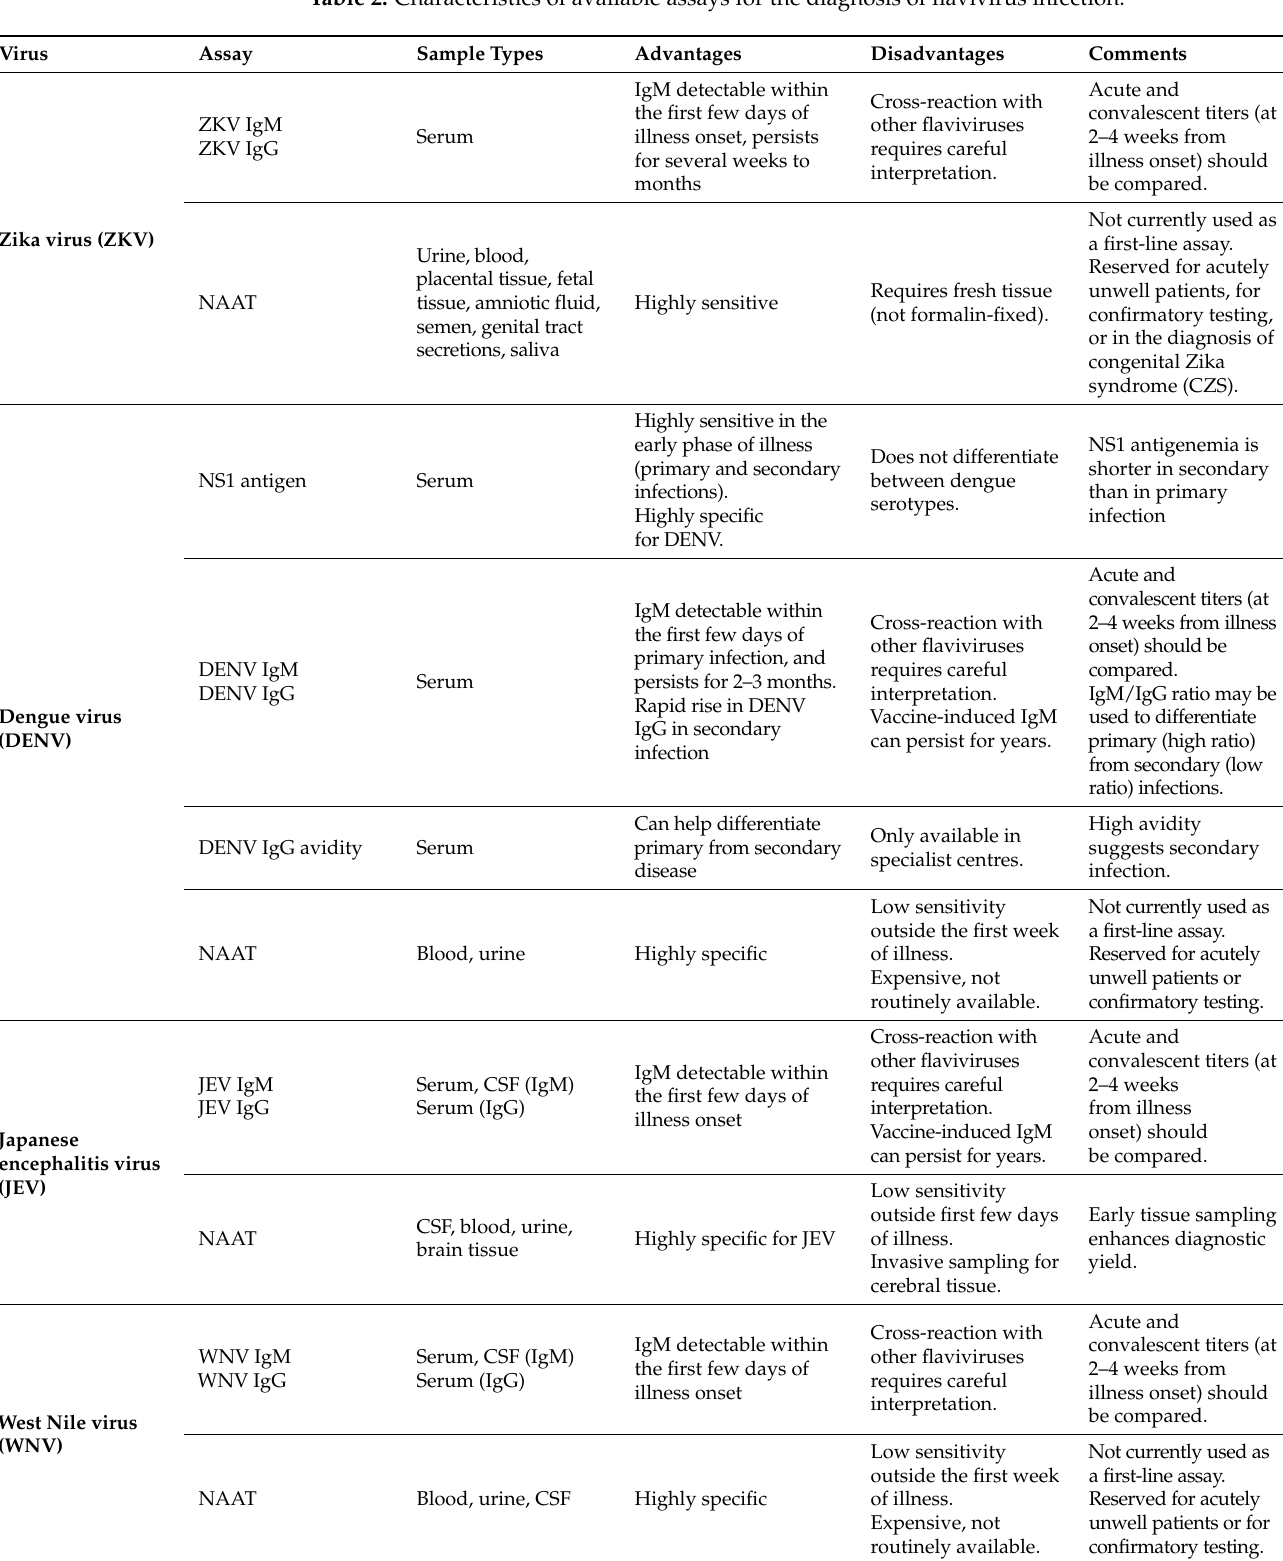
Table 2. Characteristics of available assays for the diagnosis of flavivirus